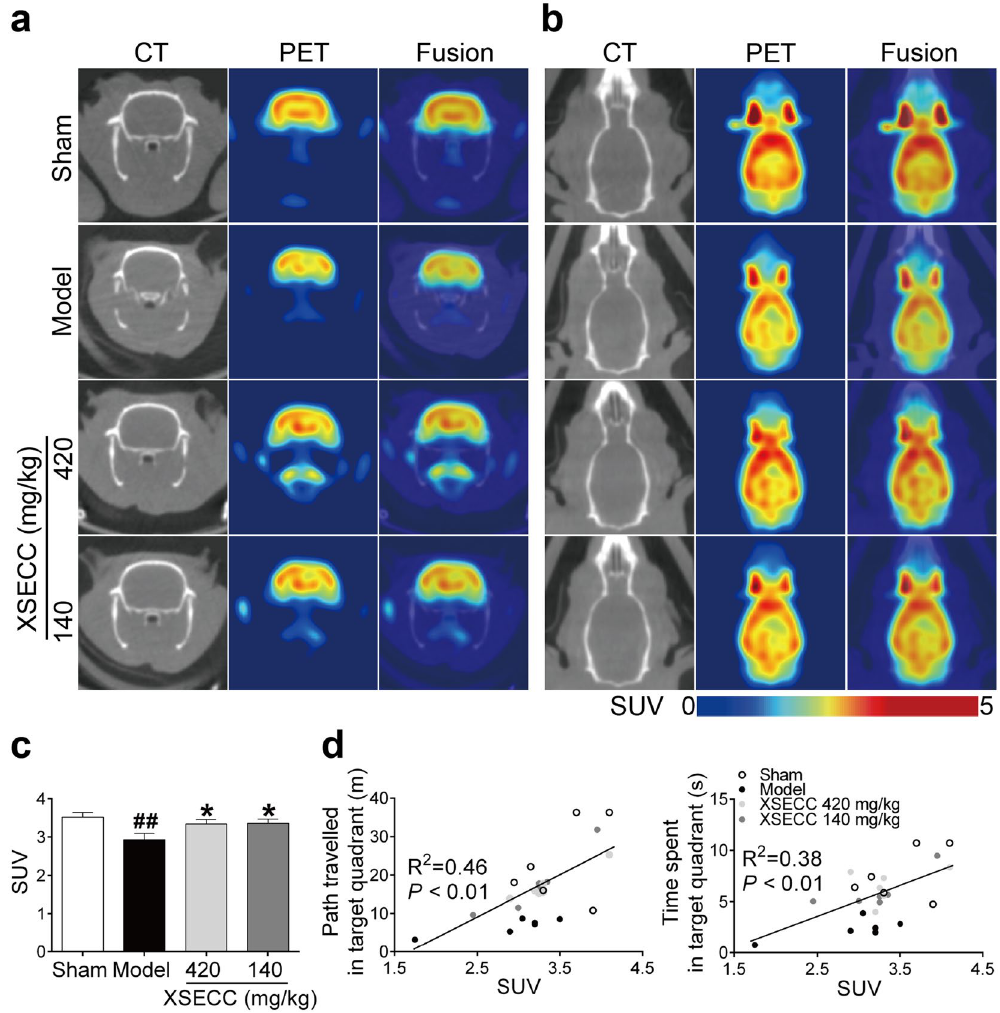
Figure 3. Effects of XSECC on glucose metabolism in BCCAO rats. 18 F-FDG PET images of the ( a ) coronal and ( b ) axial planes. PET images are co-registered with the CT of the same animal to localize anatomically the PET signal. ( c ) Quantitative analysis of SUV of 18 FDG in the hippocampus. ## P < 0.01 vs . sham group; * P < 0.05, ** P < 0.01 vs . model group (one-way ANOVA followed by LSD’s post hoc test, n = 6 per group). ( d ) Person correlational analysis of the hippocampal SUV and Morris water maze parameters of the probe test. A positive correlation was found between the hippocampal SUV and path (Pearson R 2 = 0.46, P = 0.0002), time spent in the target quadrant (Pearson R 2 = 0.38, P = 0.0013) of the probe test (Pearson correlational